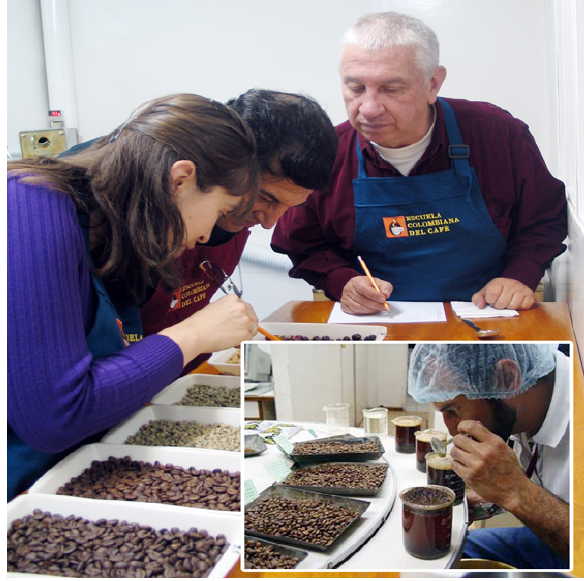
Figure 1. Professional Colombian coffee tasters